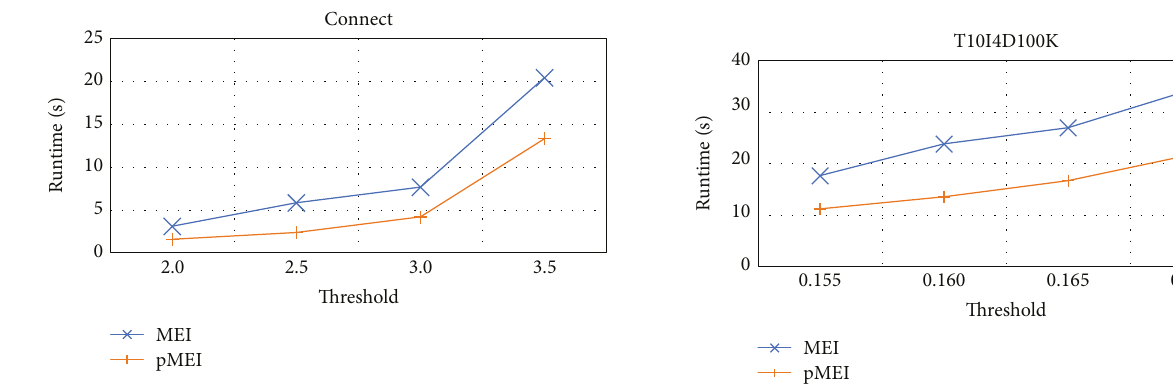
Figure 7: Runtimes of the MEI and pMEI methods on the T10I4D100K.